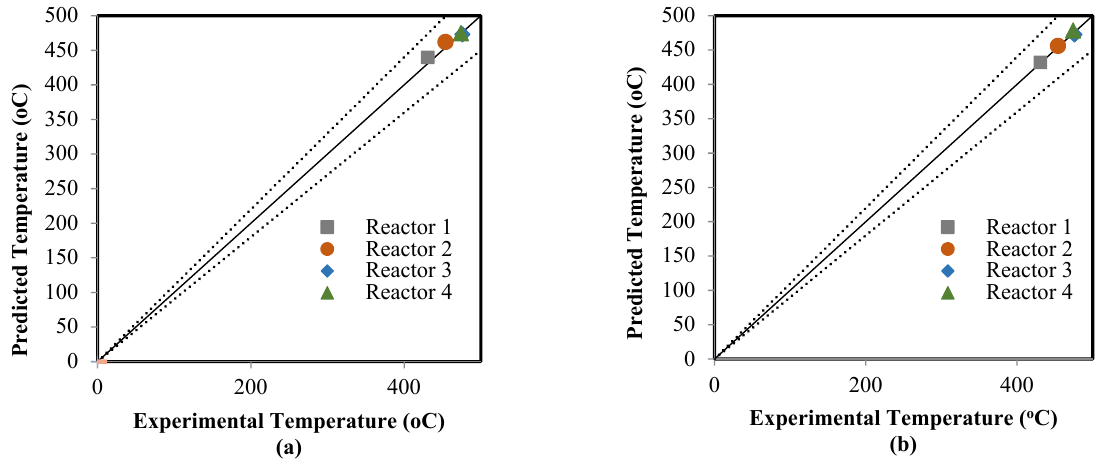
Figure 7. Comparison between the real and predicted temperatures: ( a ) mathematical model, and ( b ) artificial neural net- work.